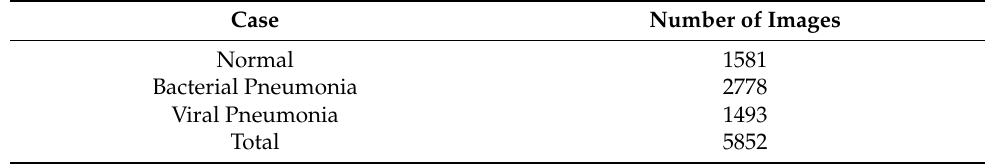
Table 1. The distribution of radiographic images used in the system.